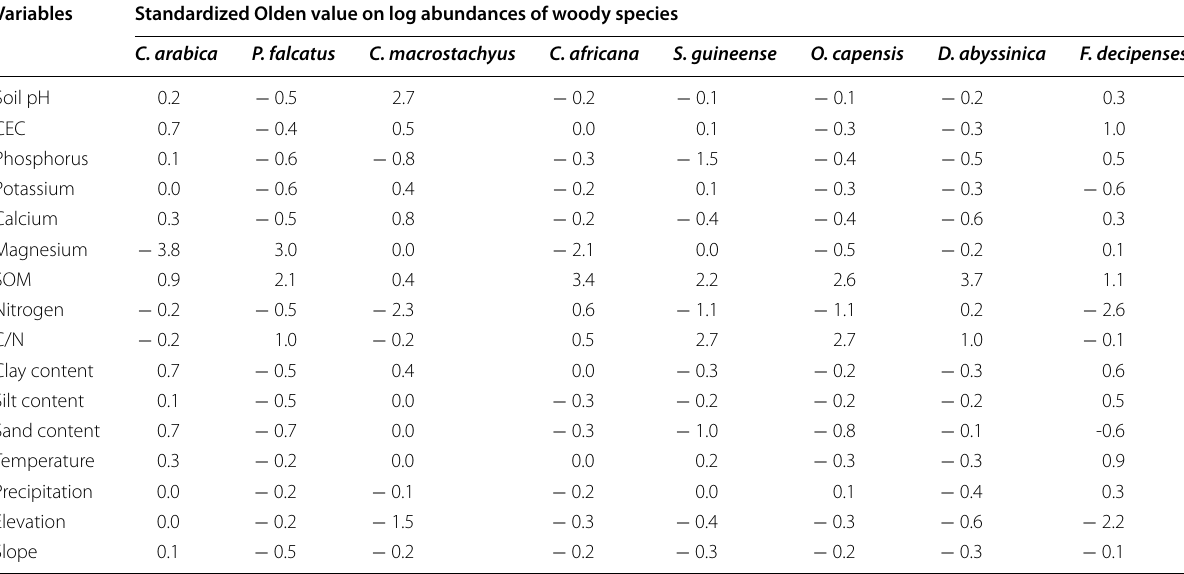
Table 3 Impacts of environmental variables on the log abundances of woody species using ANNs